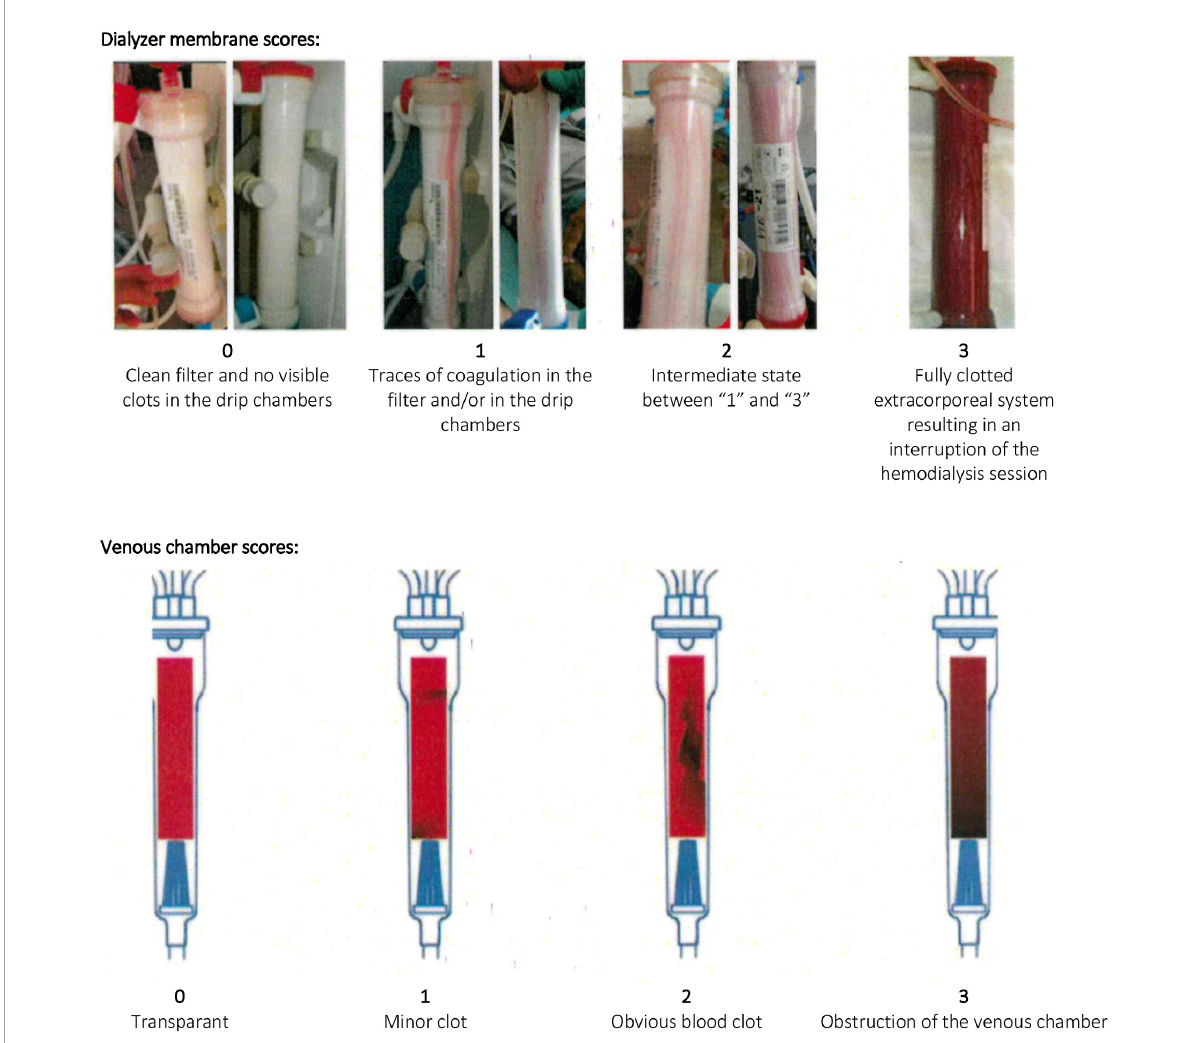
FIGURE1 Semiquantitative scoring system for dialyzer membrane and venous chamber. During the quality improvement project, the hemodialysis nurses scored both the dialyzer and the venous chamber after each hemodialysis session according to the above scoring scheme. Scores were noted on the electronic data sheet of the hemodialysis